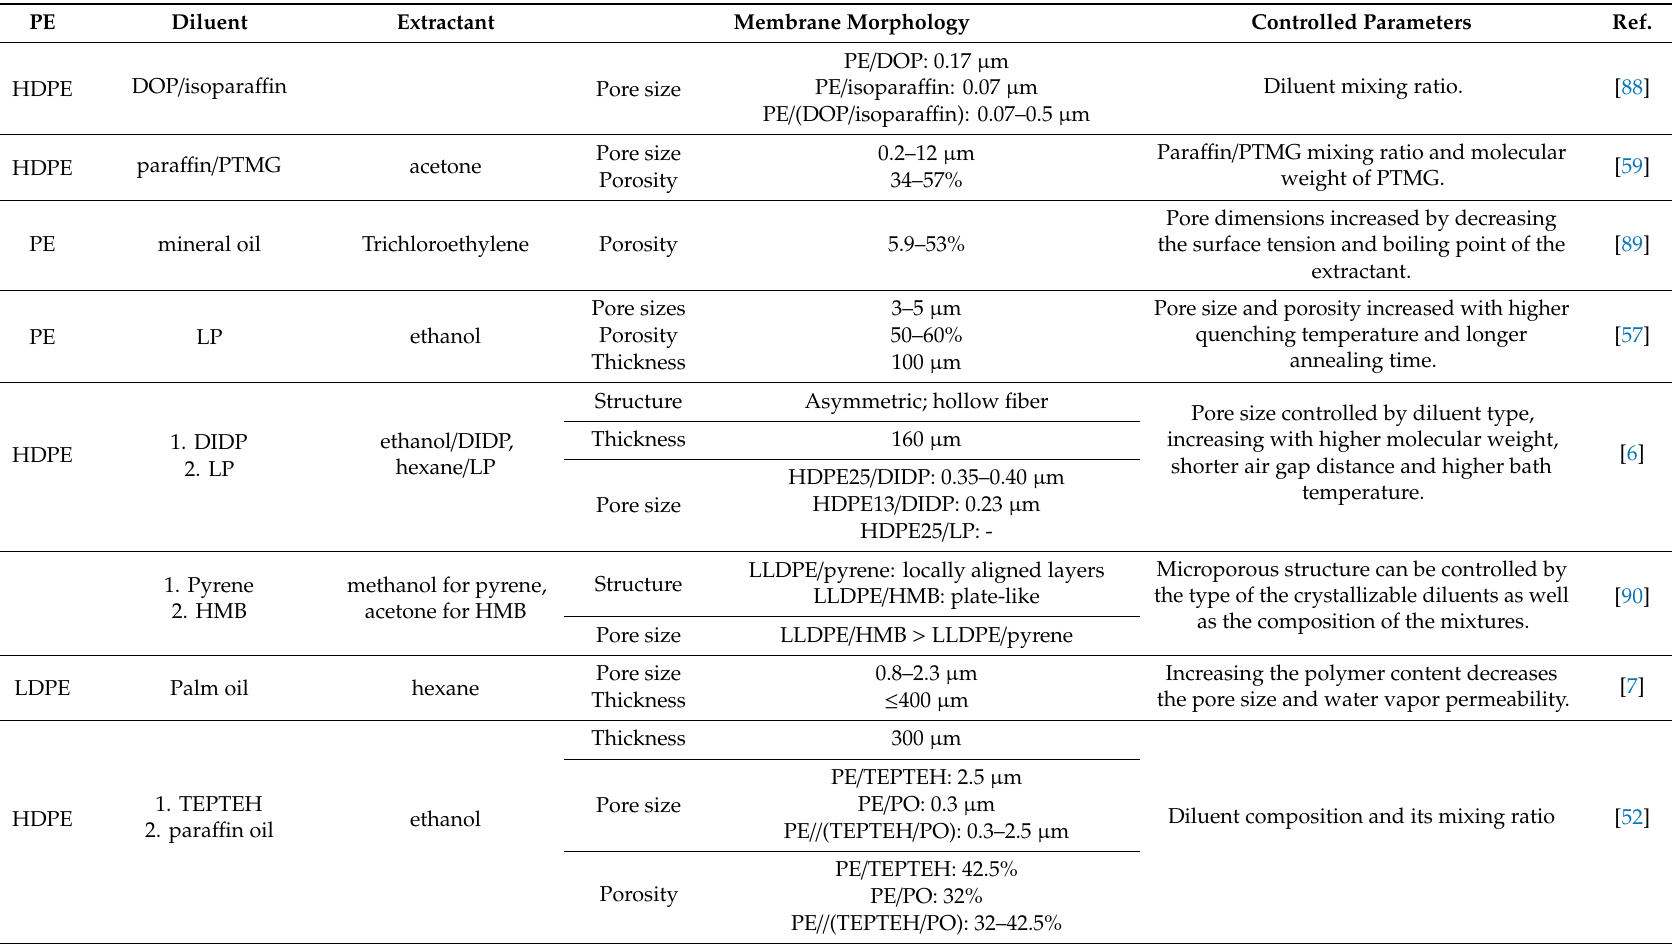
Table 3. Recent investigations on the e ff ect of polymer–diluent composition on PE membrane